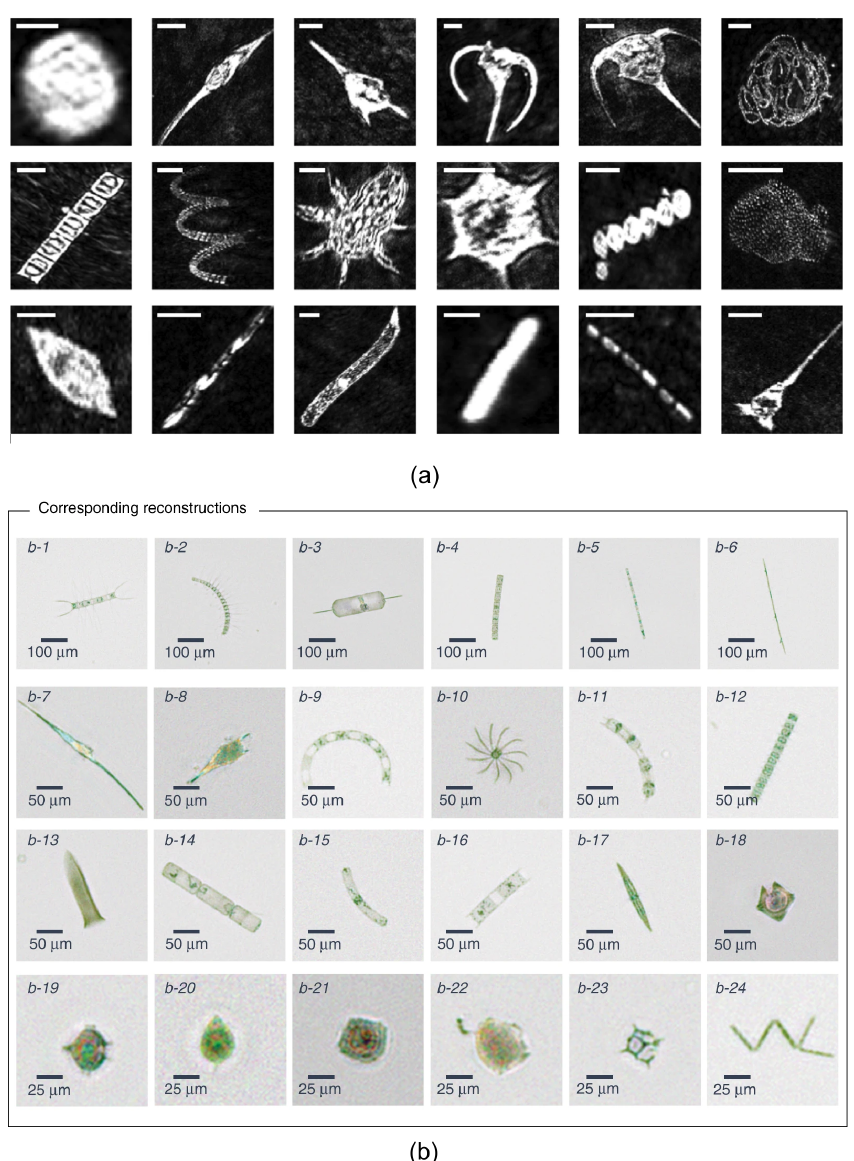
Figure 11. Examples of various ocean planktons. ( a ) Amplitude images reconstructed and detected from specific focal planes for each plankton class. From top left to lower right: Alexandrium tamarense, Ceratium fusus, Ceratium lineatum, Ceratium longpipes, Ceratium sp., Chaetoceros socialis, Chaetoceros straight, Chaetoceros sp., Crustacean, Dictyocha speculum, Melosira octagona, Parvicorbicula socialis, Pro- rocentrum micans, Pseudo-nitchzia arctica, Rhizosolenia setigera, Rods, Skeletonema costatum, Tintinnid. All images are segmented to 128 × 128 pixels and scale bars represent 50 µm. ( b ) Planktons de- tected at the Los Angeles coastline, represented by their phase-contrast reconstructions following phase recovery. The organisms were identified as ( b1 ) Chaetoceros lorenzianus, ( b2 ) Chaetoceros debilis, ( b3 ) Ditylum brightwellii, ( b4 ) Lauderia, ( b5 ) Leptocylindrus, ( b6 ) Pseudo-nitzschia, ( b7 ) Cer- atium fusus, ( b8 ) Ceratium furca, ( b9 ) Eucampia cornuta, ( b10 ) Bacteriastrum, ( b11 )